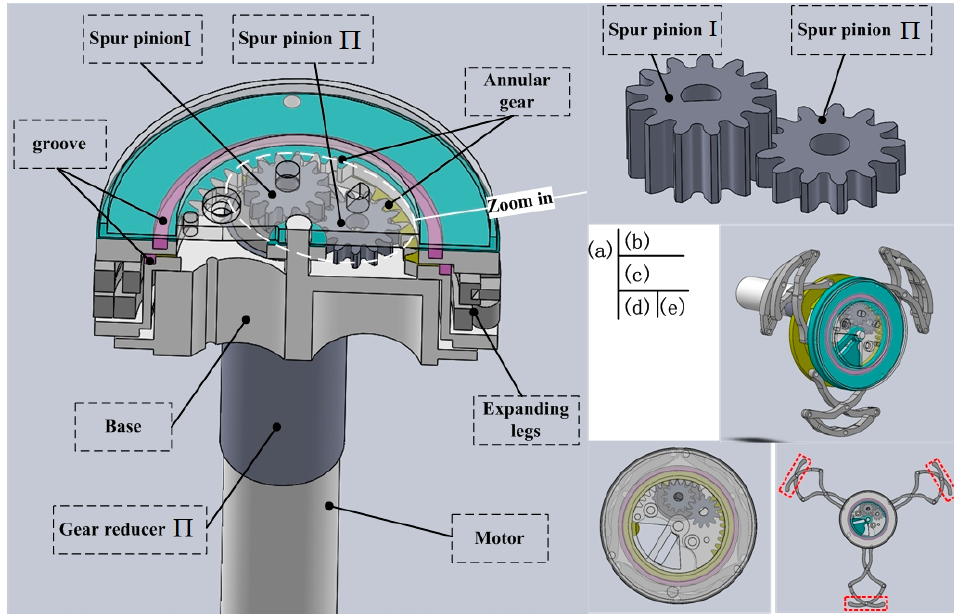
Figure 4. Structure of the designed expanding mechanism. ( a ) Section view of the expanding mechanism, ( b ) zoom in on two-layer gear transmission, ( c ) three sets of legs driven by one pair of annular gears; ( d ) and ( e ) are original state and expansion state of two-layer expanding legs, respectively.